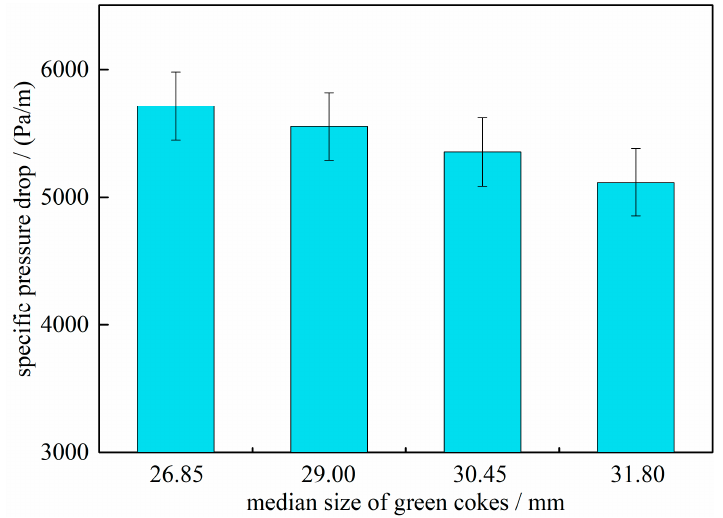
Figure 9. Relationship between specific pressure drop and green coke size.